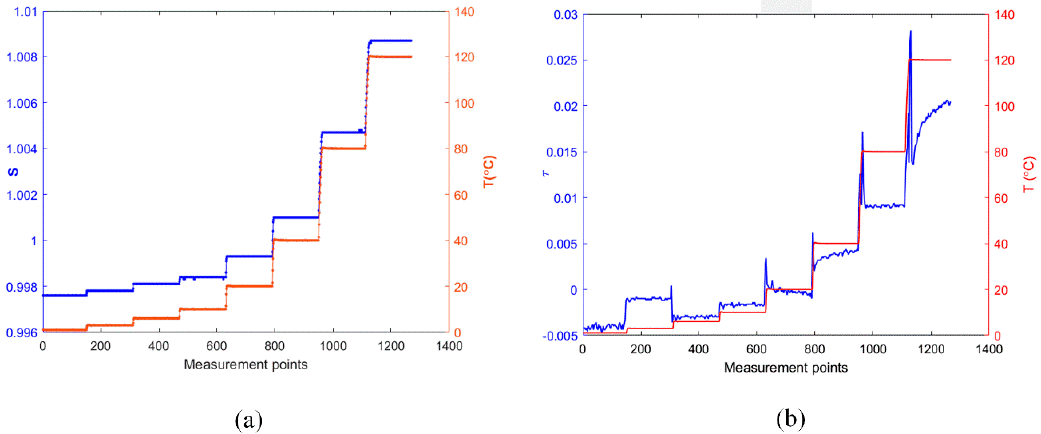
Figure 7. Real time responses of S scaling ( a ) and τ ( b ) parameter.